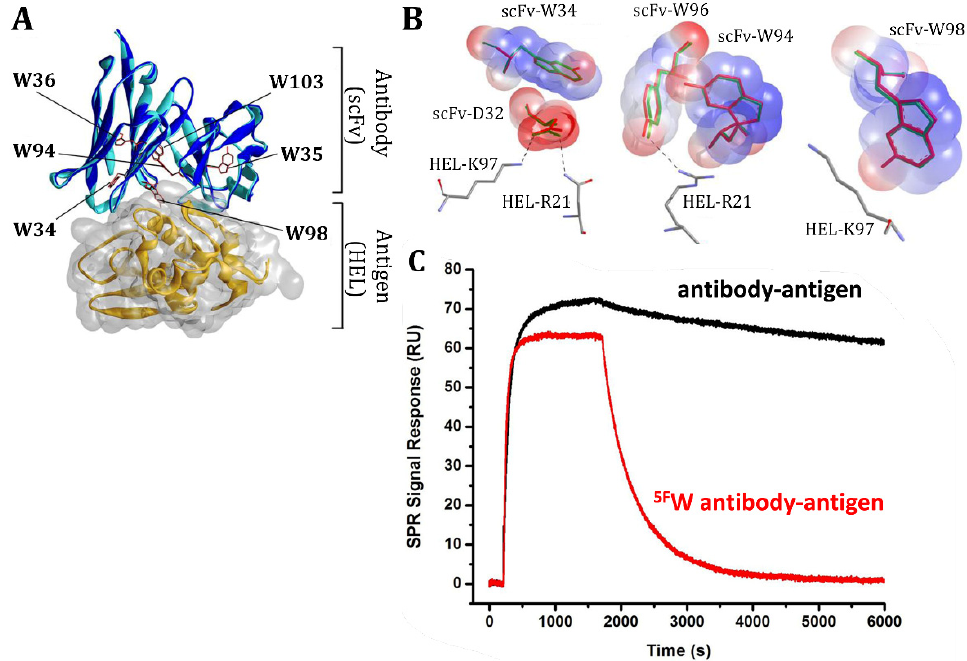
Figure 14. Crystal structures of the antibody-HEL complexes and SPR surface plasmon resonance binding data. ( A ) Ribbon depiction of antibody-HEL complex overlaid with 5F W mutations. Antibodies are colored dark blue and cyan, and HEL is colored yellow. Six fluorinated tryptophan residues are annotated. ( B ) Expansions of three key tryptophan residues. Unmodified antibody is colored green and 5F W-mutated antibody is colored red. HEL residues are colored gray. Magnification shows any possible steric or electronic influence on the antibody’s interaction with HEL. ( C ) Surface plasmon resonance data demonstrating the impact of complete tryptophan replacement with 5F W on antibody-antigen binding over 6000 s. Reprinted with permission from [72]. Copyright 2012 American Chemical Society.